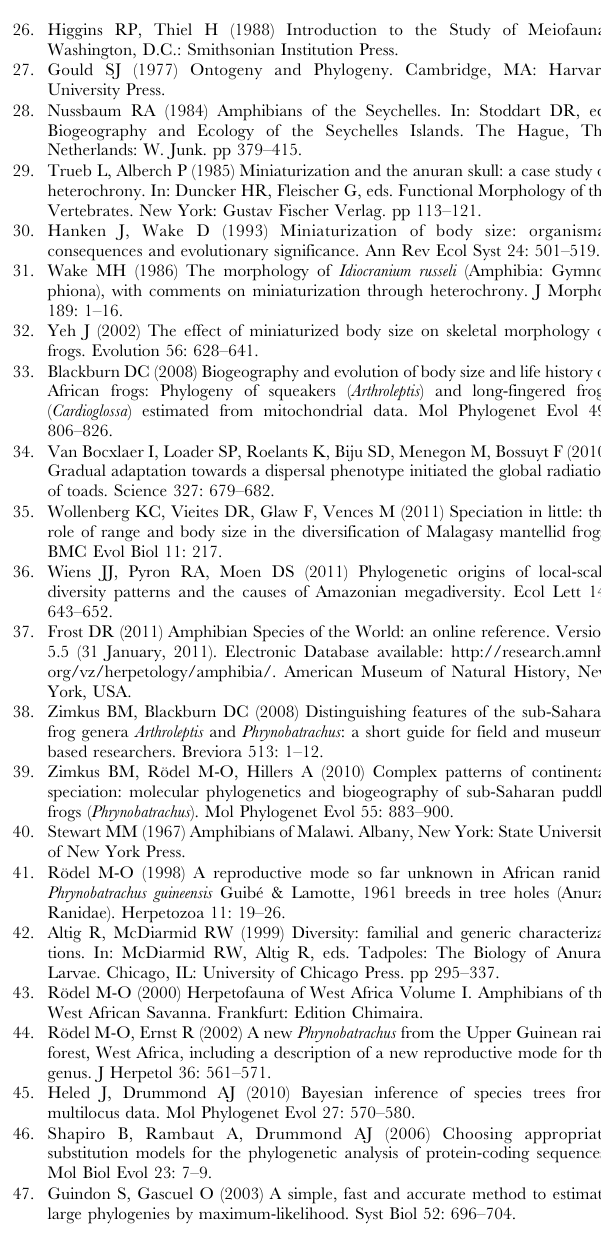
indicates the fraction of trees for which that node is not present; nodes with equivocal reconstructions are indicated in grey. The three major clades of puddle frogs (A–C) are indicated.